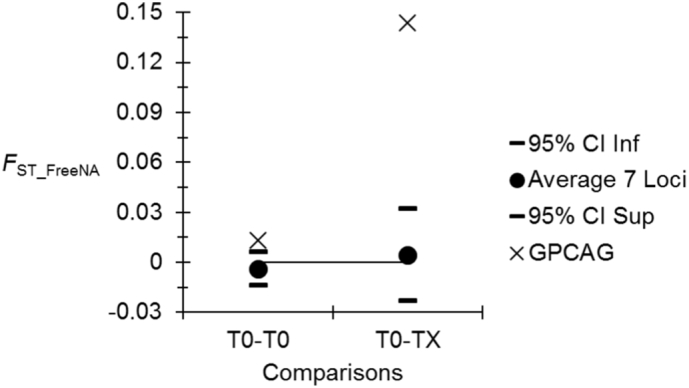
Average subdivision measures corrected for null alleles with FreeNA (FST_FreeNA) between T0 subsample pairs (T0-T0) (before treatment campaigns) (black circles) with the seven loci kept for all analyses and 95% confidence intervals (dashes), for GPCAG alone (crosses) and between T0 and TX subsample pairs (T0-TX) (X = 1, 2, 3 or 4).